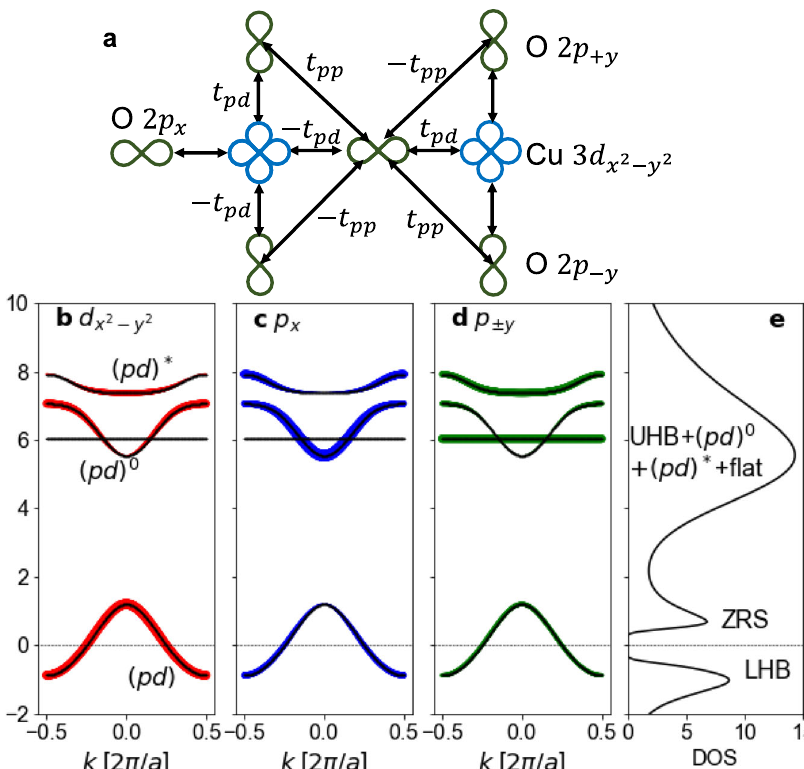
Fig. 1 The multi-orbital model for the corner-shared cuprate spin chains. a A sketch of the four-orbital Cu − O pd -model describing the corner-shared spin-chain cuprates like Sr 2 CuO 3 . Panels b − d plot the noninteracting band structure in hole language and at half- fi lling. In each panel, the weight of the Cu 3 d and O 2 p x and 2 p ± y orbitals are indicated by the weight of the colored overlays. Panel e shows the density of states (DOS) of the pd -model with interactions at half- fi lling, obtained from determinant quantum Monte Carlo (DQMC) simulations at T = 0.0625 eV. Here, LHB (UHB) and ZRS denote the portions of the spectra corresponding to the lower (upper) Hubbard band and the Zhang-Rice Singlet quasi-particle band, while " fl at" indicates portions of the electronic structure arising from the non-bonding oxygen 2 p y fl at band appearing in panel ( d ). The model parameters for the noninteracting bands are the onsite energies ϵ d = 0, ϵ p , x = 3, and ϵ p , y = 3.5, and the hopping integrals ∣ t ( p , x ) d ∣ = 1.5, ∣ t ( p , y ) d ∣ = 1.8, and ∣ t pp ∣ = 0.75. For the DOS shown in panel e , we set the onsite Hubbard interactions on Cu and O to U d = 8 and U p = 4, respectively, and the interorbital Cu − O Hubbard interaction to U pd = 1. All parameters are given in units of